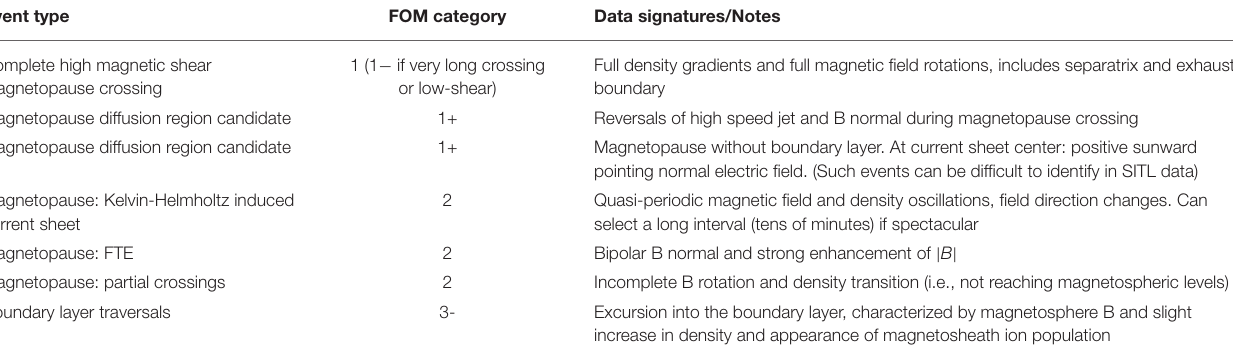
TABLE 1 | Guidelines used during Phase 5A (30 September 2019 through 24 November 2019) specifying how the SITL should classify magnetopause